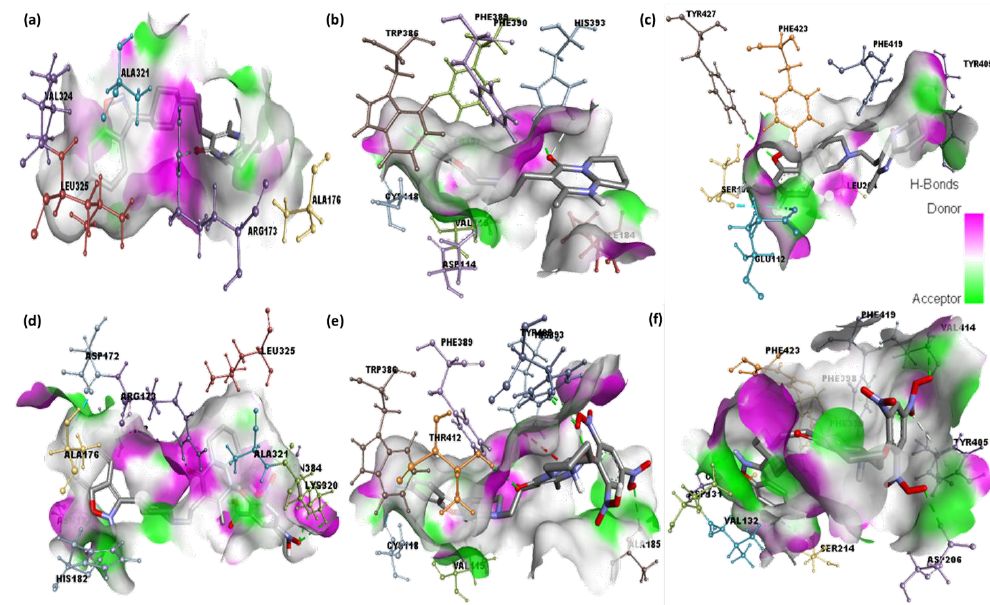
Figure 8. Representations of hydrogen bonding surfaces of serotonin, dopamine, and adrenergic receptors docked with ( a – c ) risperidone and ( d – f ) CTcS complex.